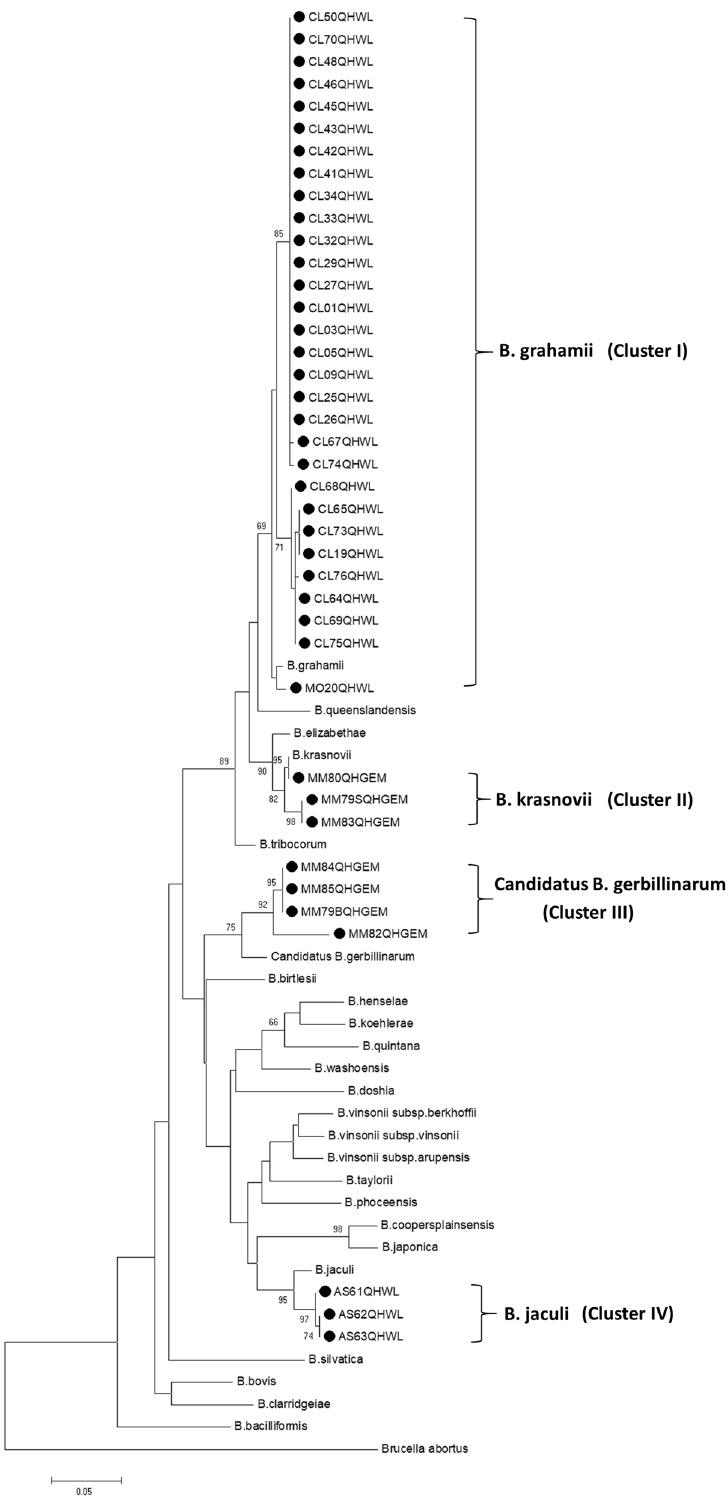
Figure 2. Phylogenetic trees constructed with concatenations of gltA , ftsZ , rpoB and ribC